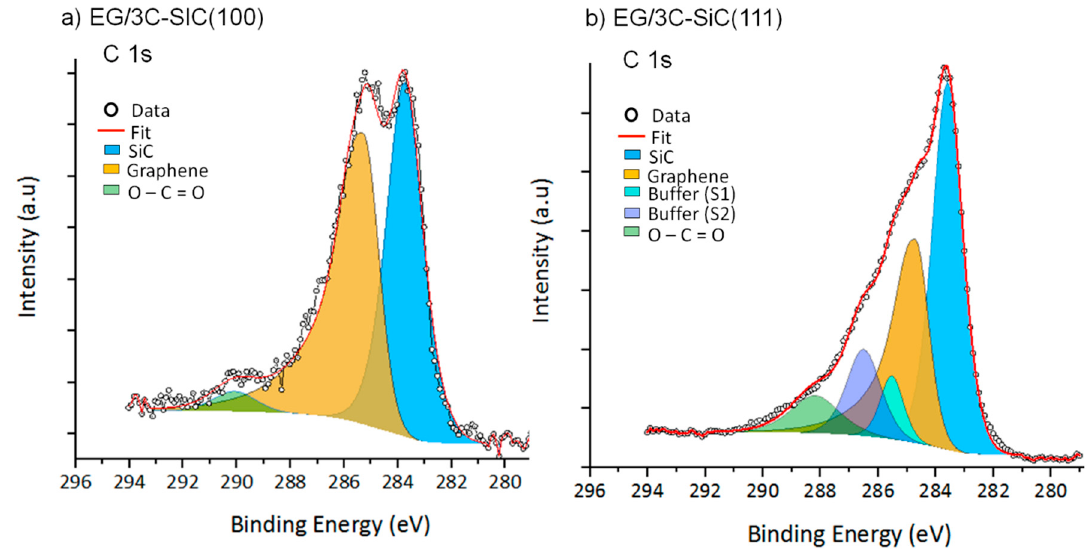
Figure 11. XPS C 1s core-level spectrum for ( a ) EG / 3C-SiC (100) and ( b ) EG / 3C-SiC (111). Bu ff er layer components are visible for EG / 3C-SiC (111). Reprinted with permission from Reference [21]. Copyright (2020) American Chemical